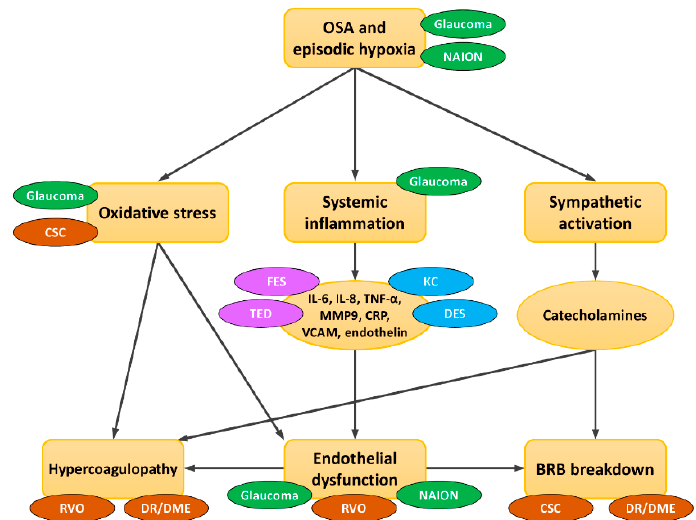
Figure 1. Schematic interactions of OSA and eye diseases in terms of common pathophysiological mechanisms. OSA has been directly/indirectly linked to many ocular diseases through three major mechanisms: oxidative stress, elevated systemic inflammation, and sympathetic activation. In glaucoma, hypoxia/hypercarbia directly damages high oxygen-depleted neuronal cells and